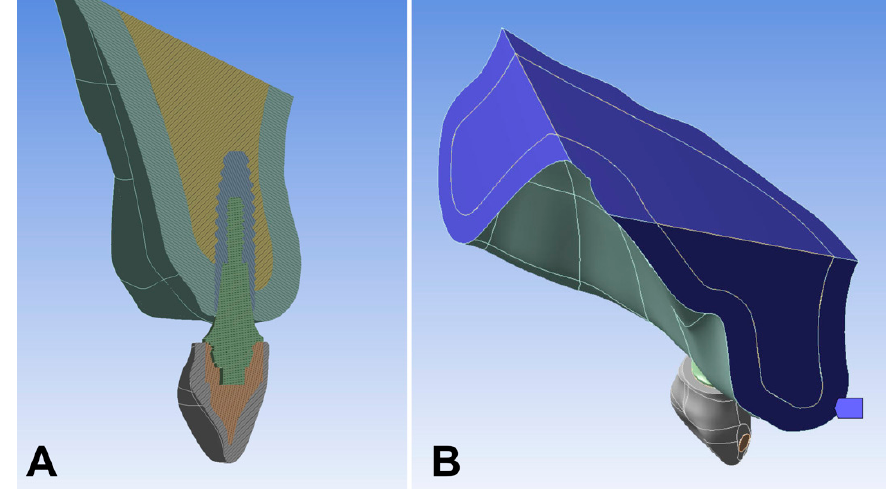
Figure 1. ( A ) Different layers of the model; ( B ) boundary conditions. The total deformation of each model was initially evaluated and convergence tests were performed to check analytical accuracy. For quantitative analysis, the implants and abutments were assessed with von Mises equivalent stress (VMES), while the bone was analyzed by maximum and minimum principal stresses. The graphic display of color maps was used to compare the models qualitatively. All graphic scales were